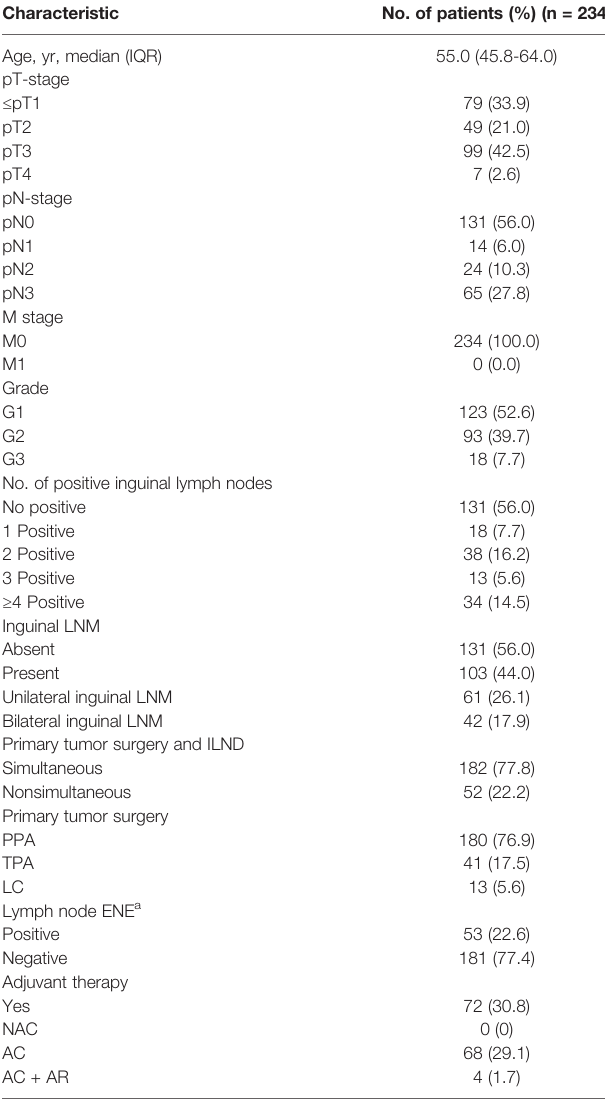
TABLE 1 | Clinical characteristics of 234 patients with penile cancer.